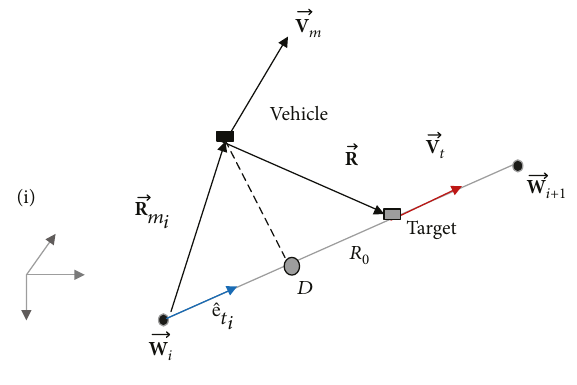
Figure 2: Straight path virtual target is always ensured to be located on the path. In = R − W Figure 2, R m m i is the relative position vector of i a vehicle from the waypoint i .